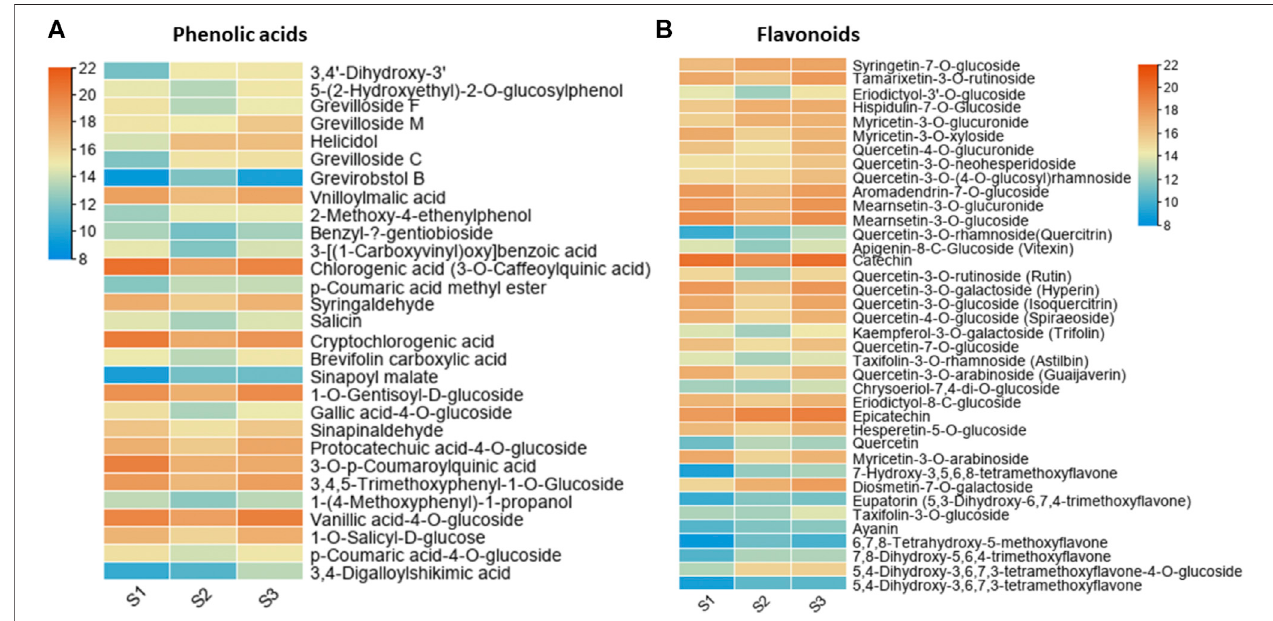
FIGURE 3 | Heatmaps of key metabolite substances at three developmental stages of M. ternifolia nutshell (A) Phenolic acids (B)